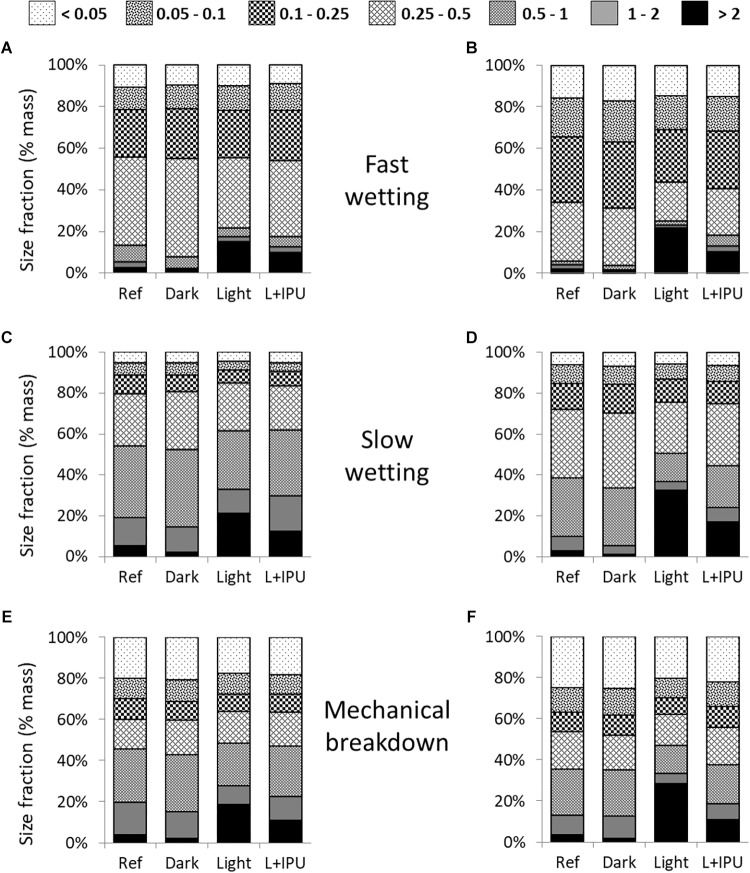
Relative distribution of the aggregate size fractions determined following three aggregate stability tests, for the reference soil aggregates (Ref, at day 0) and soil aggregates from Organic (A,C,E) or Conventional (B,D,F) cropping systems (n = 3), at the end of microcosm incubations (day 50) under the different conditions (Dark, Light, Light + IPU, see Table 1 for acronym description). For a better graphical understanding, the standard deviations and statistical analyses were only shown for the largest aggregates (>2 mm) in Table 2.